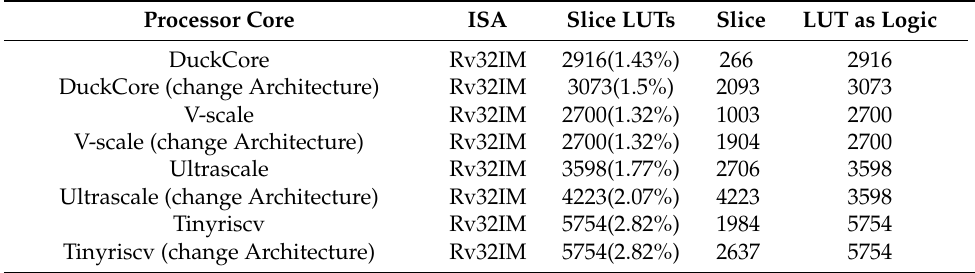
Table 2. Comparison of resources occupied by fault-tolerant solutions of different open-source cores. Processor Core